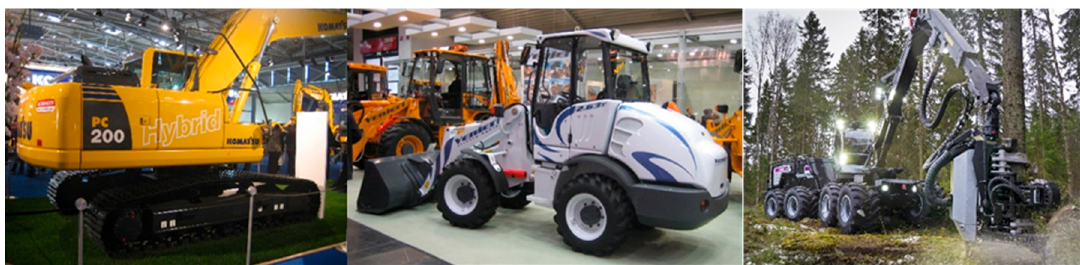
Figure 3. Examples of hybrid mobile machines: Komatsu hybrid excavator (Photo: Antti Lajunen), Venieri hybrid wheel loader (Photo: Antti Lajunen), and Logset 12H GTE Hybrid forest harvester (Photo: Logset http://www.logset.com).